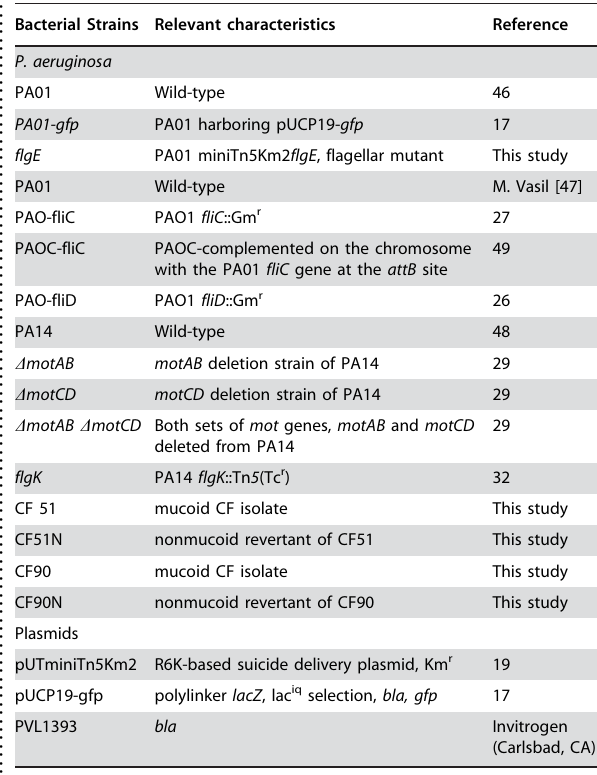
Table 1. Bacterial Strains and Plasmids Used ... ... ... .... ... ... .... ... ... .... ... ... .... ... ... .... ... ... .... ... ... . Bacterial Strains Relevant